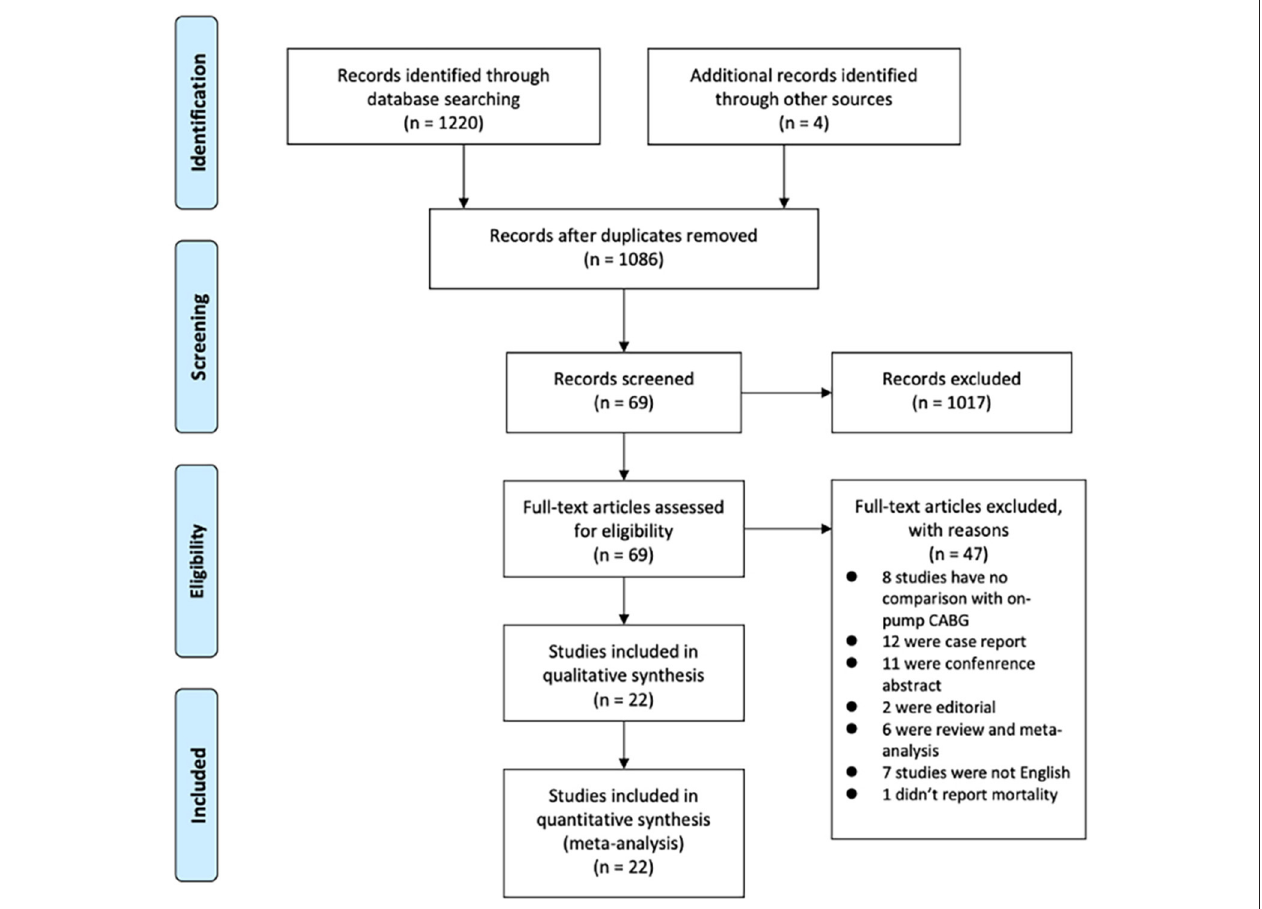
FIGURE 1 | Preferred Reporting Items for Systematic Reviews and Meta-analyses (PRISMA) study selection flow